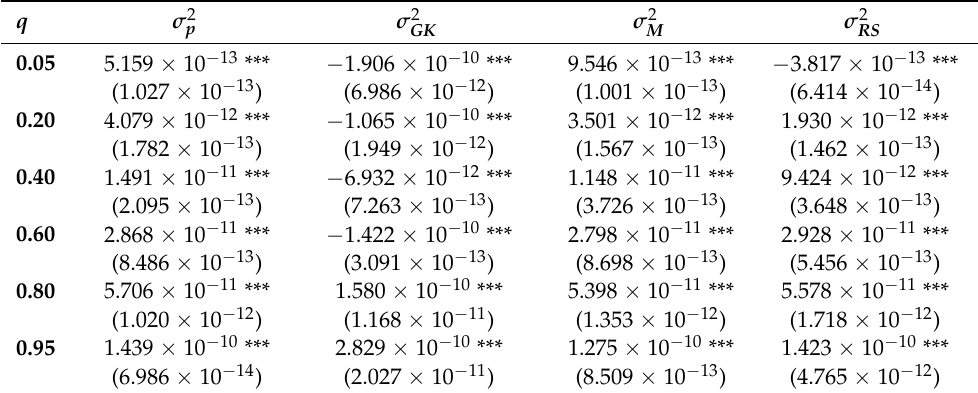
Table 2. Trading volume impact on Alpha Bank’s stock return volatility.